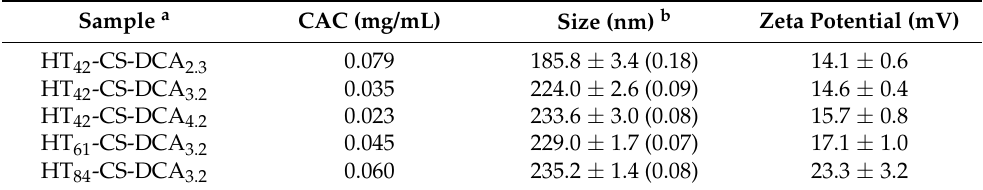
Table 1. CAC, size, and zeta potential of HT-CS-DCA nanoparticles. Sample a CAC